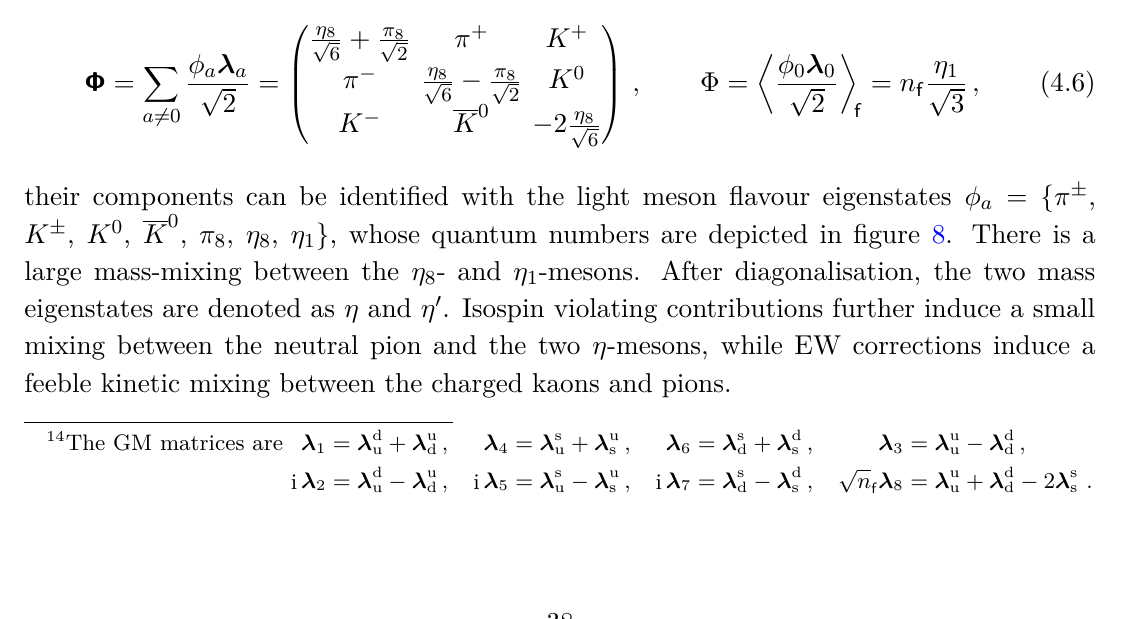
, η , and η ) mix into the neutral mass 8 8 1